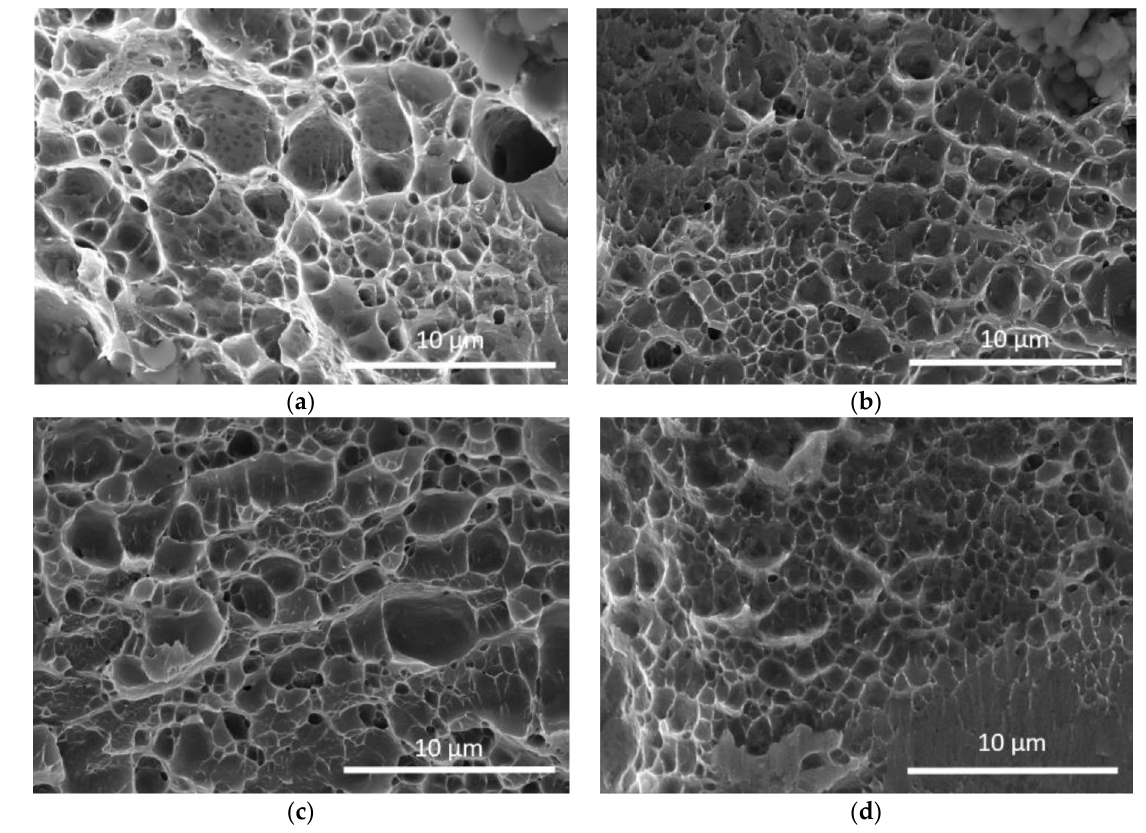
Figure 9. Fracture surfaces observation by SEM of T6 tempered: ( a ) 1-Hom. alloy A(0.1Zr); ( b ) 1-Hom. alloy B(0.05Sc); ( c ) 2-Hom. alloy A(0.1Zr); ( d ) 2-Hom. alloy B(0.05Sc).